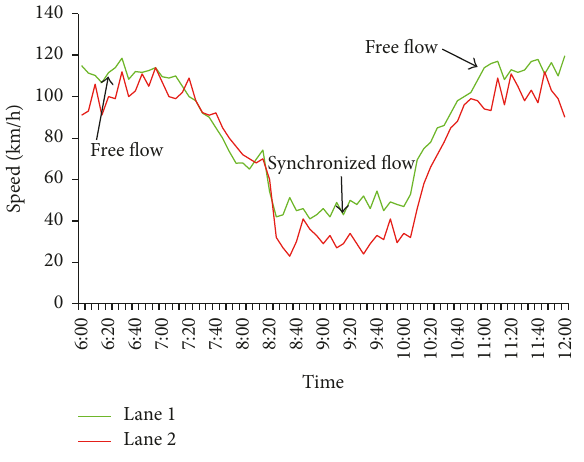
Figure 4: Speed characteristics of lateral